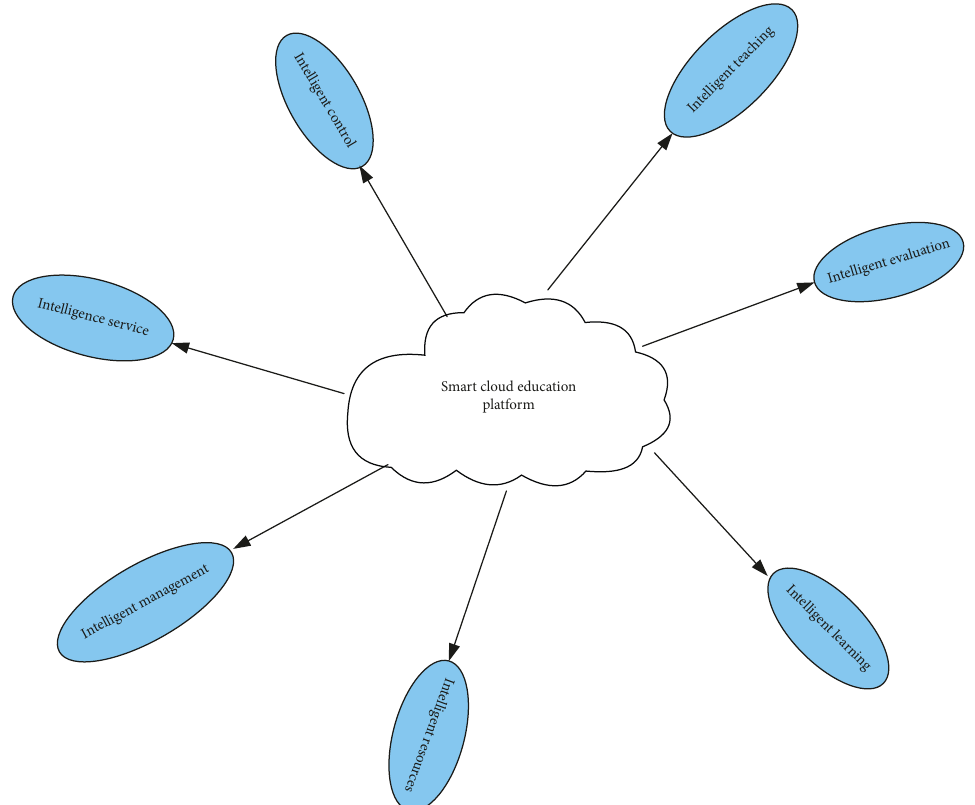
Figure 6: Functions of smart cloud